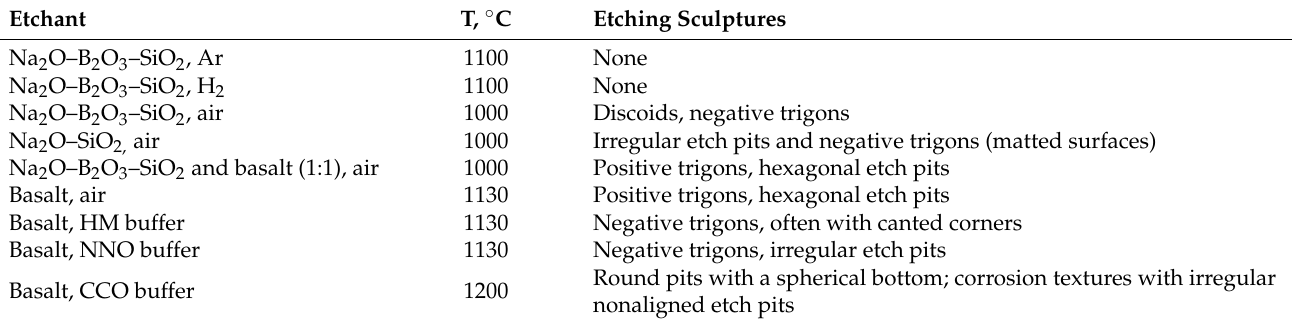
Table 1. Surface sculptures on {111} faces of diamonds etched in silicate melts at 0.1